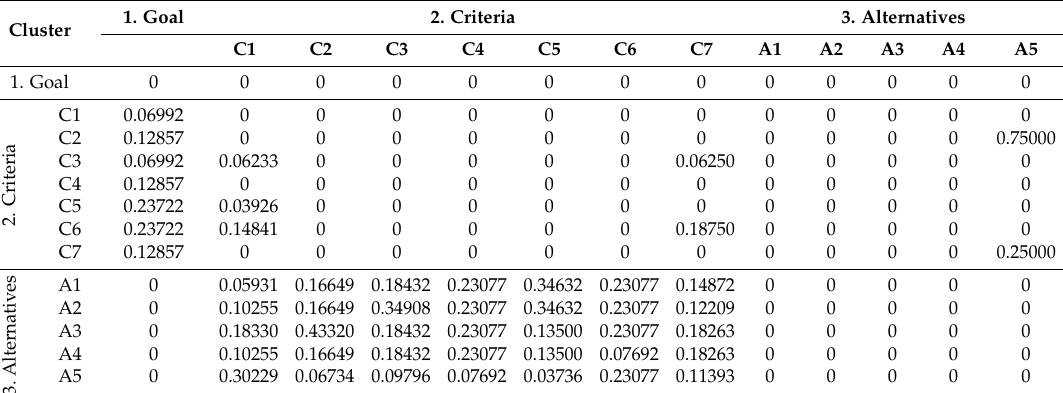
Table A2. Weighted